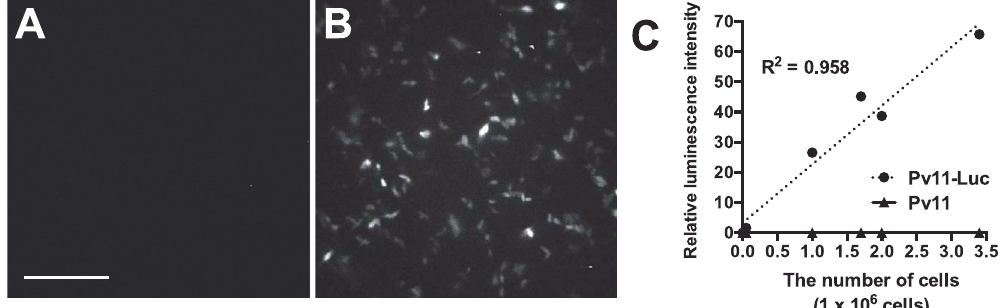
Figure 1. Generation of Pv11 (Pv11-Luc) cell line stably expressing luciferase. Pv11 cells transfected with the pPG121K-Luc plasmid were cultivated in insect medium with G418 for 3 weeks. Bioluminescence of normal Pv11 cells ( A ) and Pv11-Luc cells ( B ) was imaged in presence of 300 µ M D-luciferin potassium salt. Exposure time was 4 min. Scale bar shows 100 µ m. ( C ) Luminescence intensity caused by luciferase was measured using Pv11-Luc cells and original Pv11 cells (i.e. absence of